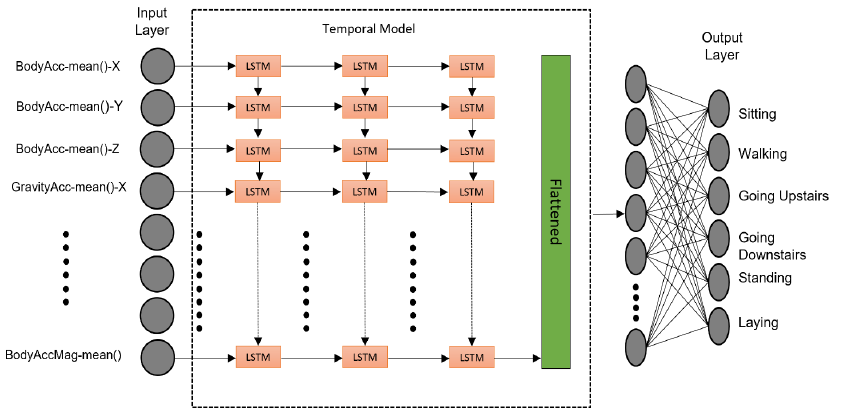
Figure 4. Architecture of the proposed LSTM model for human activity